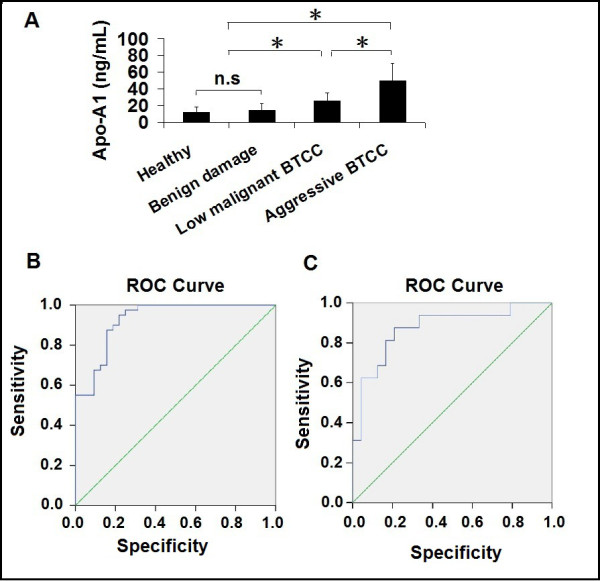
Apo-A1 as a biomarker for predicting and classifying BTCC. (A) Quantitative proteomic analysis of Apo-A1 in urine samples by ELISA. *P < 0.01, Student's t-test. (B) Urianry Apo-A1 distinguishes bladder cancer on independent series of urine samples of patients with BTCC and controls. ROC curve of urinary Apo-A1 as a detection marker for bladder cancer was based on a series of 72 urine samples. Among these, 40 had cancer-positive. The optimal cutoff was 18.22 ng/ml, and the AUC obtained was 0.928 (95% CI 0.870-0.986). (C) Urinary Apo-A1 classifies with a different series of urine samples of patients with low malignant or aggressive BTCC. ROC curve of urinary Apo-A1 as a detective classification marker for BTCC was based on a series of 40 urinary specimens, which consists of 24 low malignant BTCC and 16 aggressive BTCC. The optimal cutoff was 29.86 ng/ml, and the AUC obtained was 0.875 (95% CI 0.758-0.992).